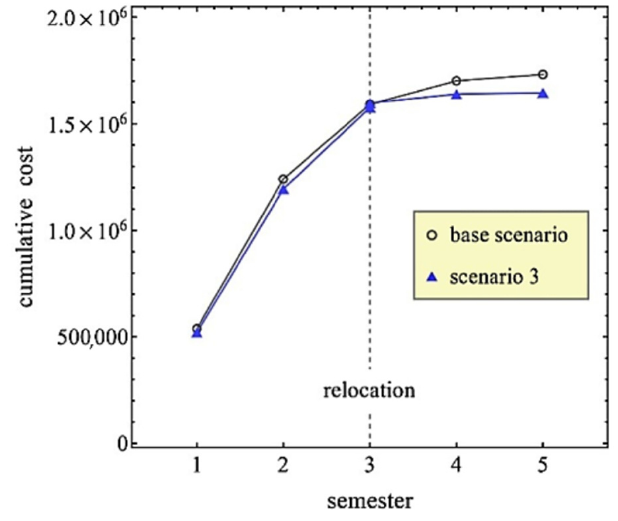
Figure 12. Comparison of cumulative costs between scenarios.